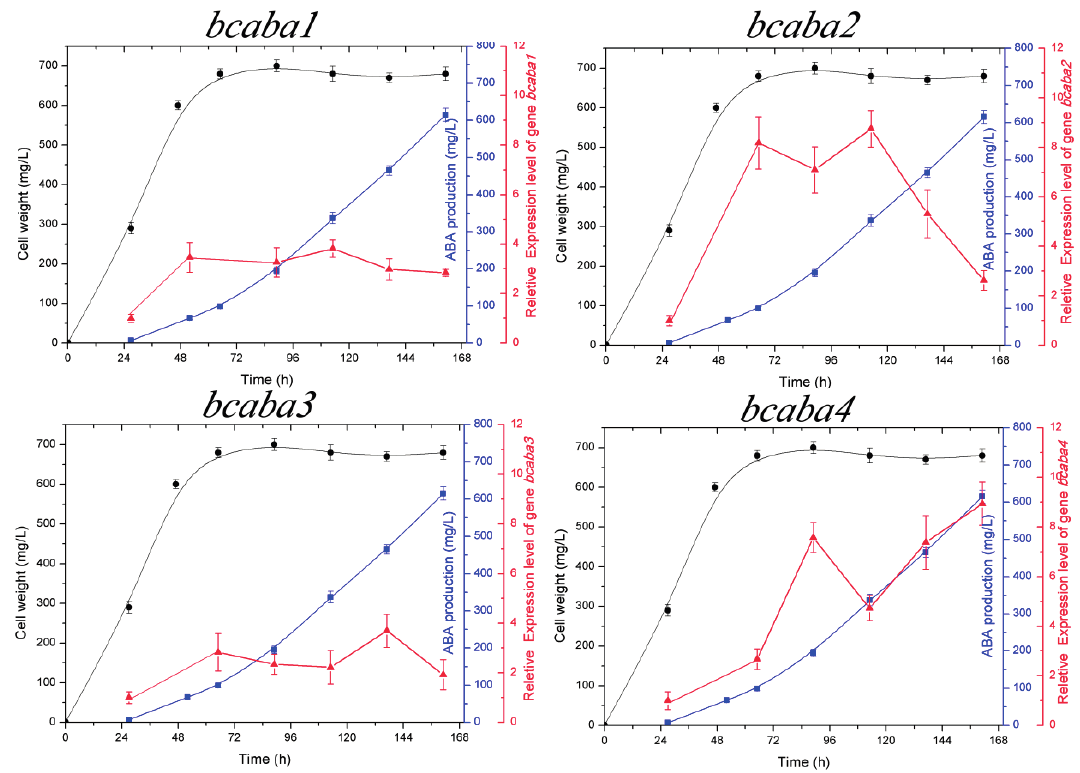
Figure 6. Expression profiles of bcaba1 , bcaba2 , bcaba3 and bcaba4 in B . cinerea TB-3-H8. cell weight, ABA production, relative expression level of bcaba1 , bcaba2 , bcaba3 and bcaba4 ,